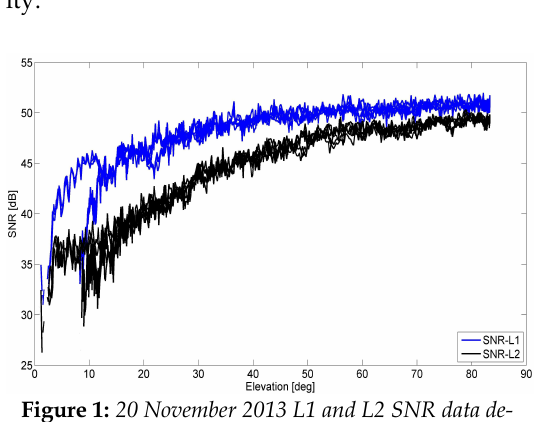
Figure 1: 20 November 2013 L1 and L2 SNR data de- rived from the EIIV station and satellite 01